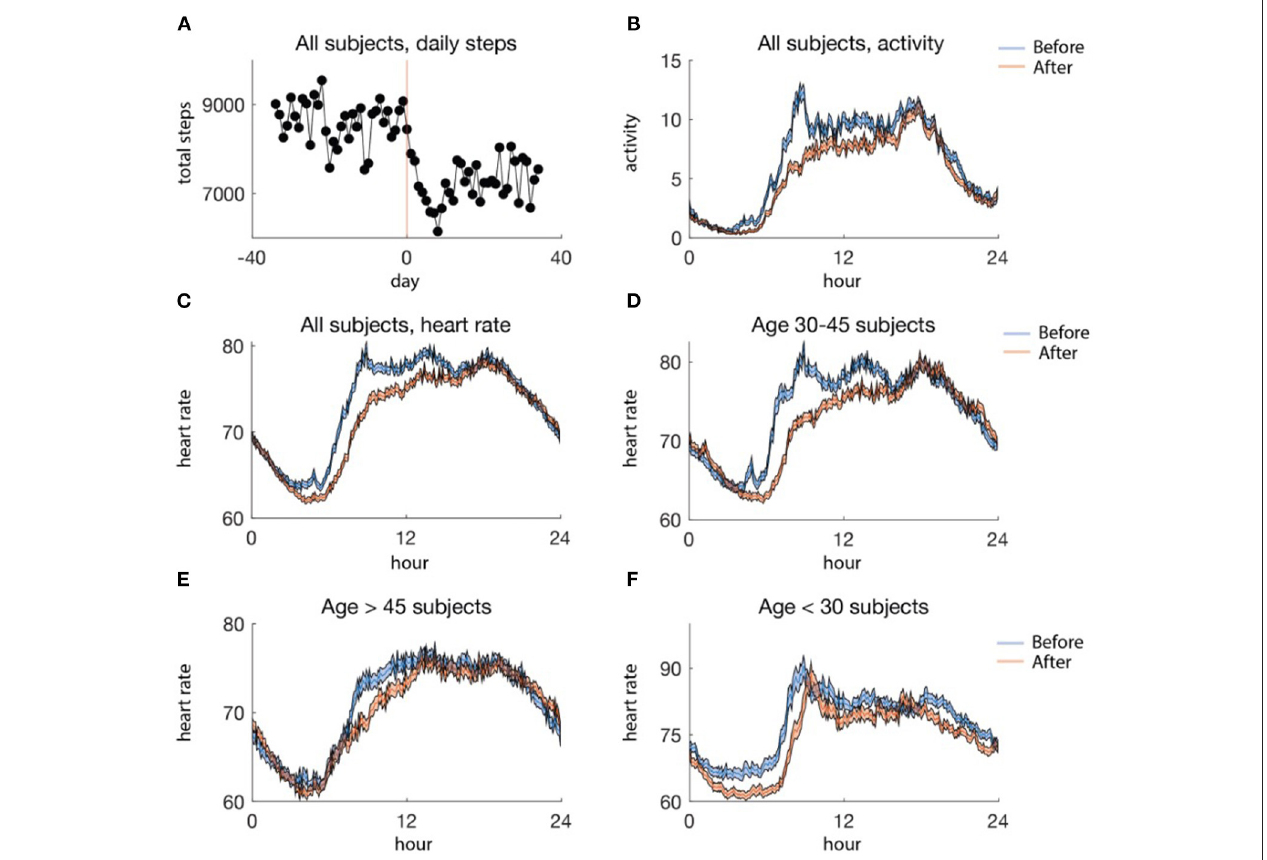
FIGURE 3 | (A) Average aggregate steps per day, aligned at the social distancing date. The red line (day 0) is the date of social distancing onset, and the black dots are the mean steps per day. (B) Activity profile, averaged by 5min for data before (blue) and after (red) social distancing. (C) Average daily heart rate profiles for all subjects binned in 5-min intervals, before (blue) and after (red) social distancing. (D–F) Average heart rate profiles binned in 5-min intervals by age group, before (blue) and after (red) social distancing. (D) includes data from 33 subjects, (E) includes data from 26 subjects, and (F) includes 13 subjects. In (B–F) the standard error of the mean is